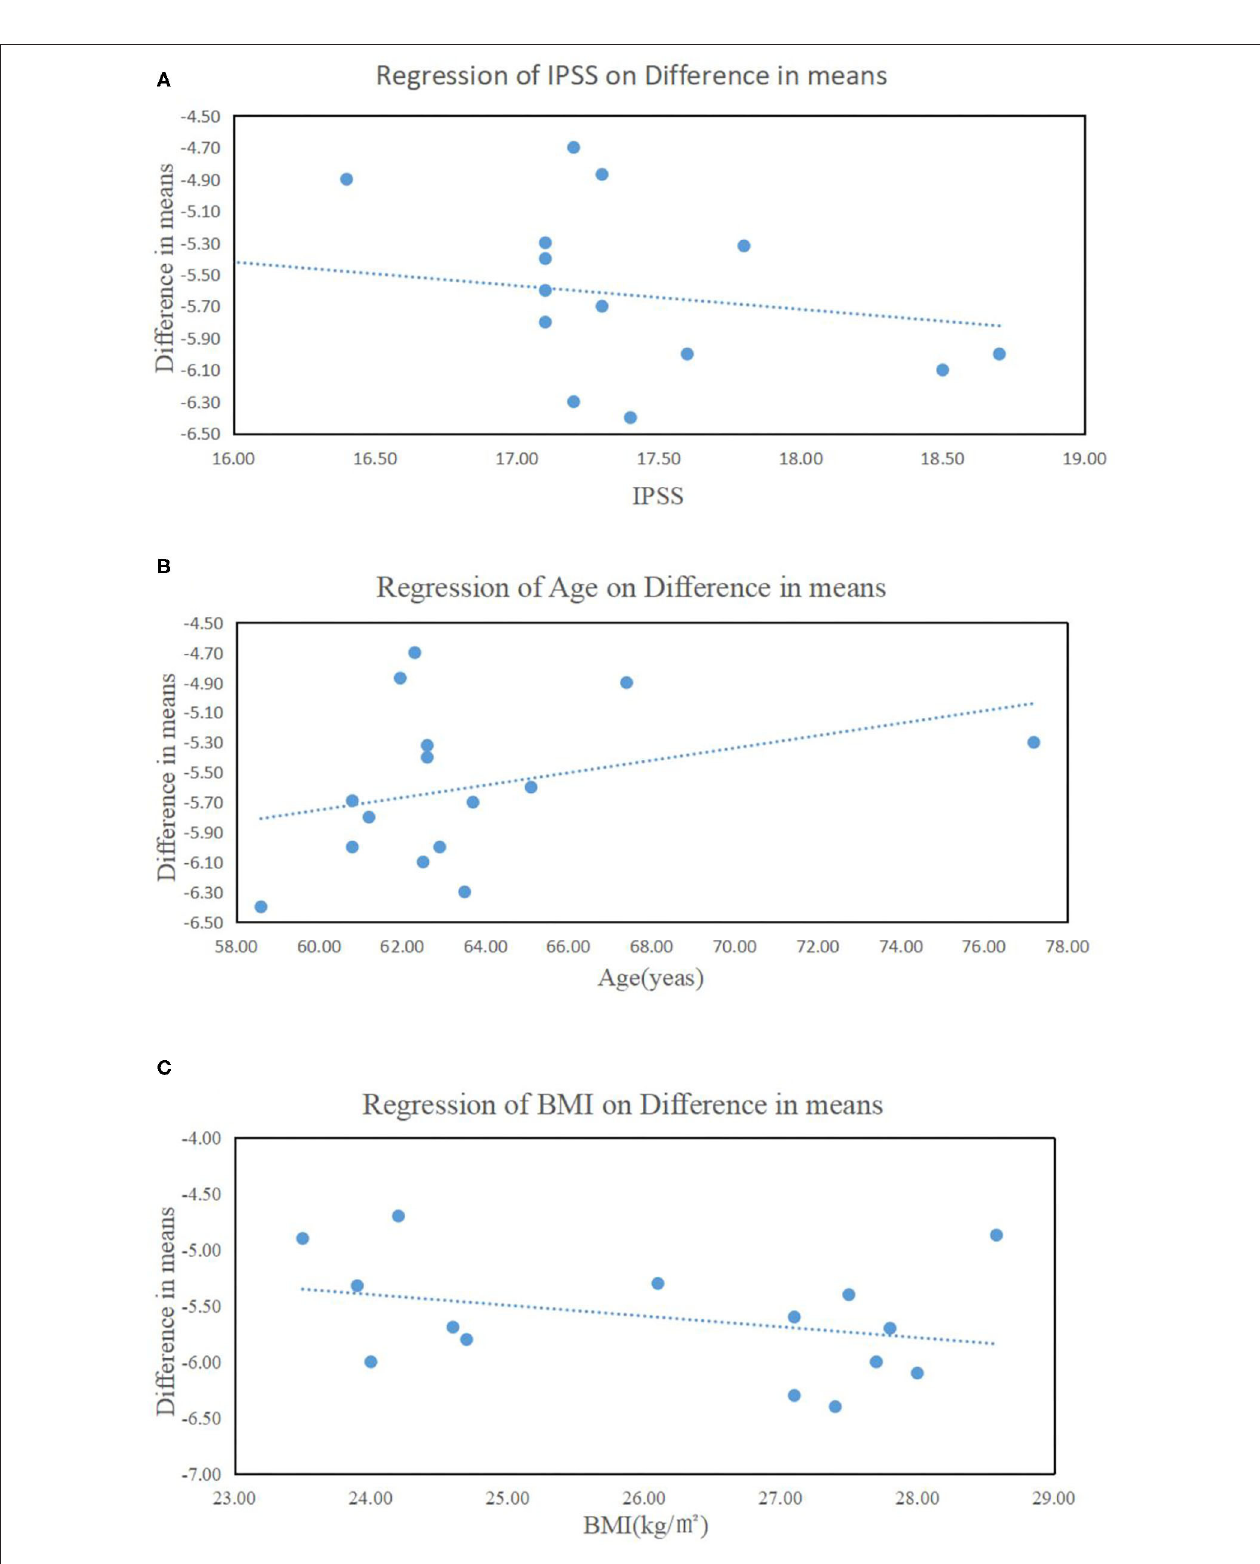
FIGURE 4 | Influence of (A) the baseline of the total International Prostate Symptom Score (IPSS), (B) age, and (C) body mass index on IPSS improvement.